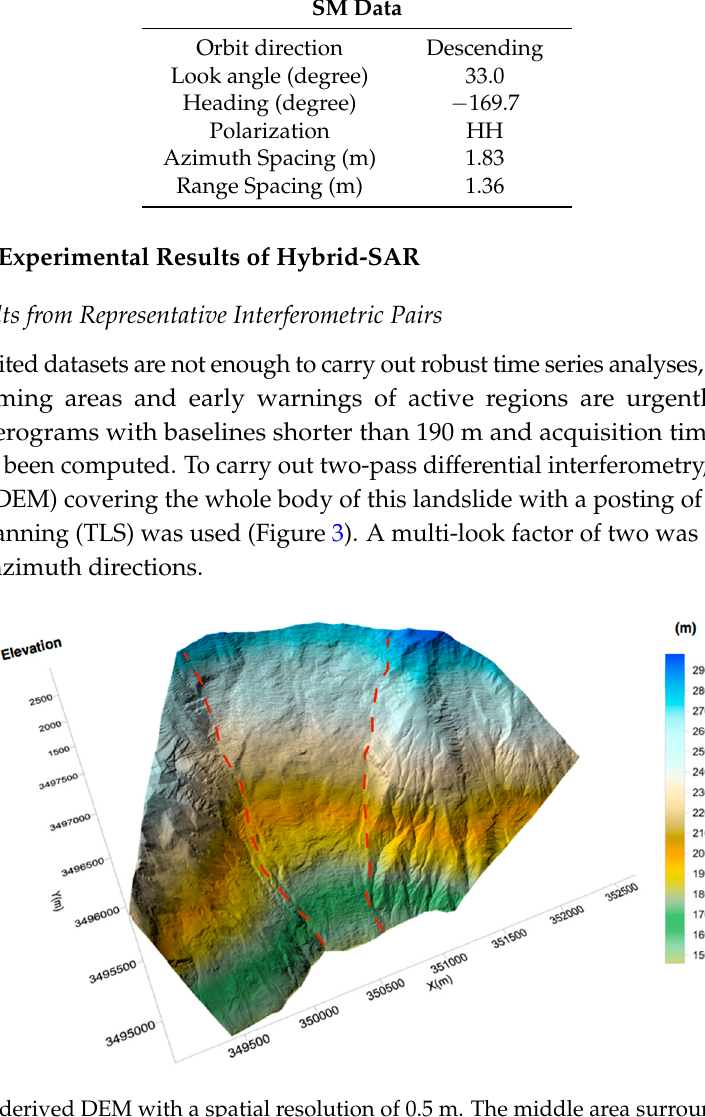
Figure 3. TLS-derived DEM with a spatial resolution of 0.5 m. The middle area surrounded by the red dashed line is the corresponding landslide location.